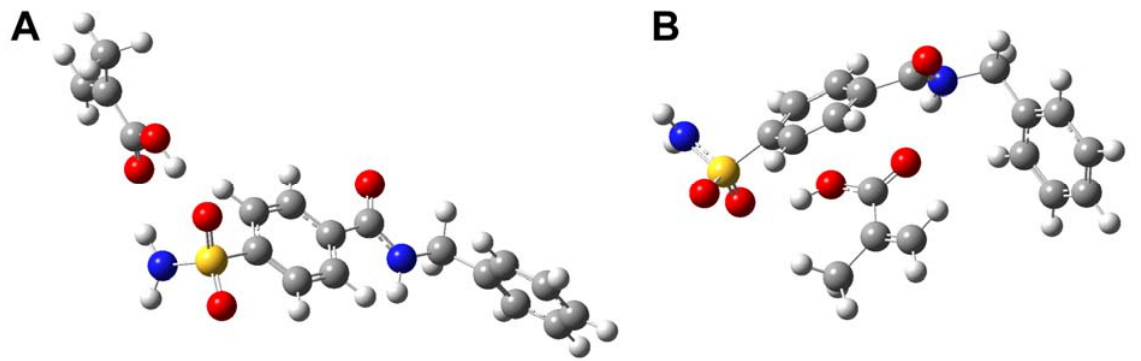
Figure 5. Geometrically optimized structures of MAA and template 1 in a two point interaction through H-bonding with carboxylic acid of MAA with the S=O and NH sulfonamide moieties (A) and H-bonding with carboxylic acid of MAA with the sulfonyl O-atom and NH of central amide moieties